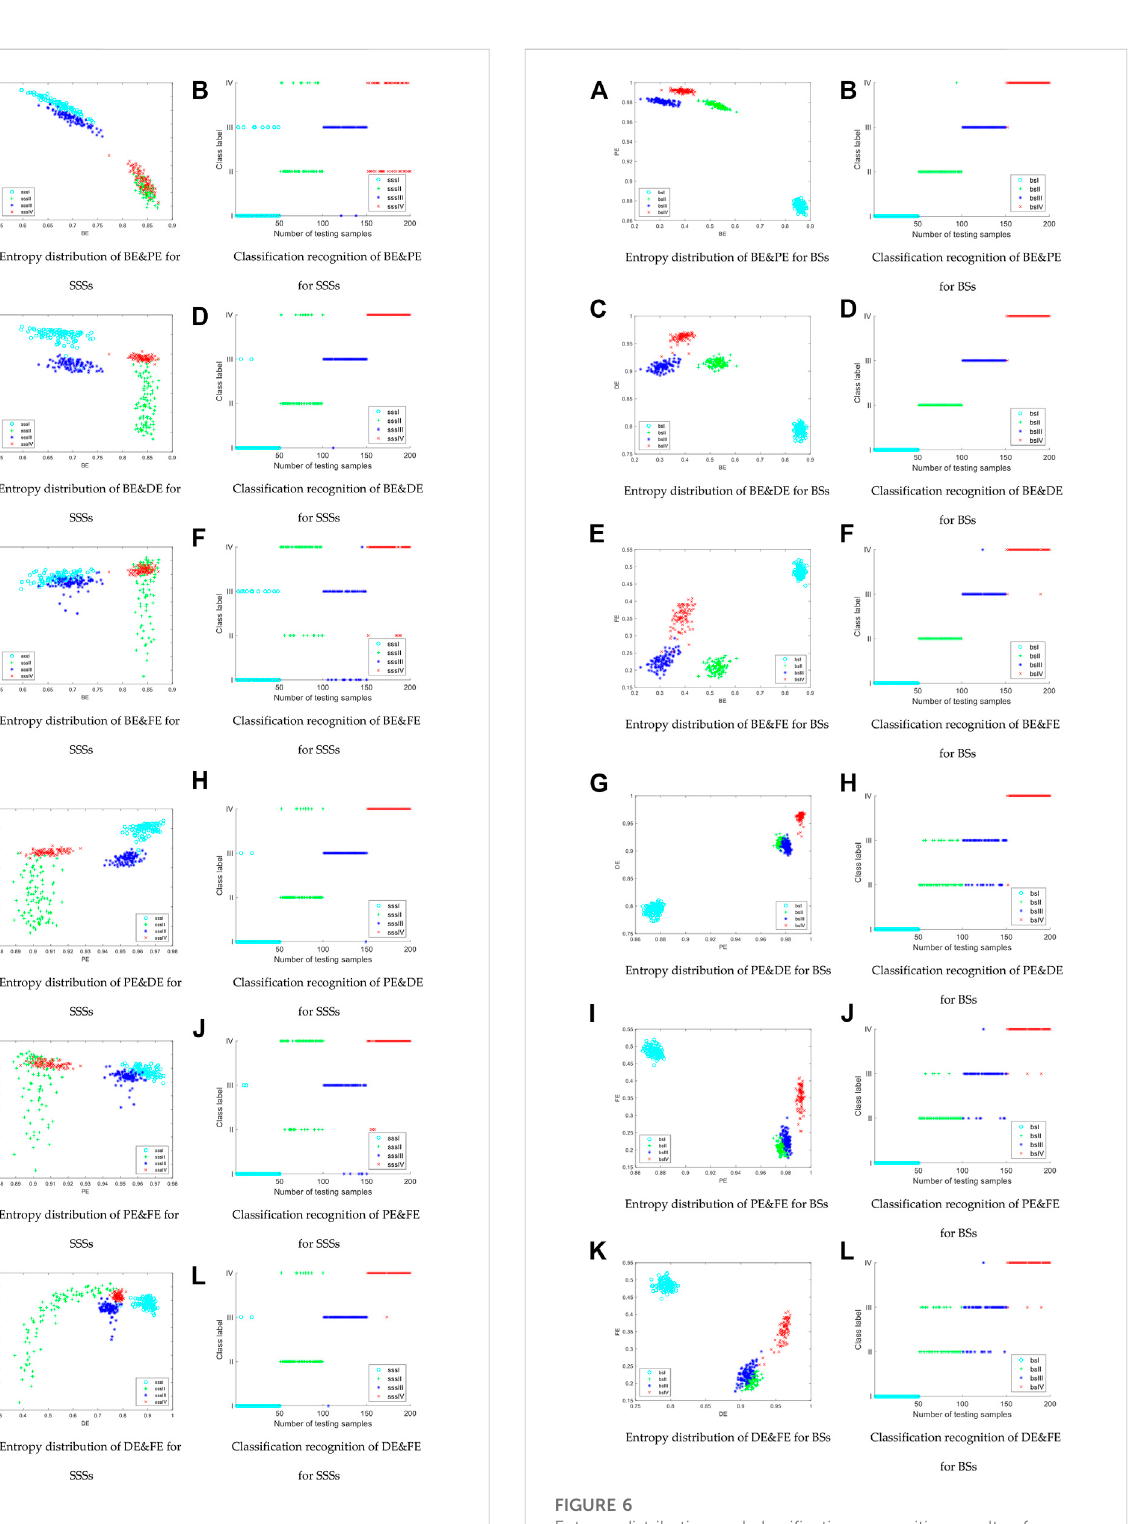
FIGURE 6 Entropy distribution and classi fi cation recognition results of BE&PE, BE&DE, BE&FE, PE&DE, PE&FE, and DE&FE of BSs: distribution of different entropy combinations (Left column); classi fi cation recognition results (Right